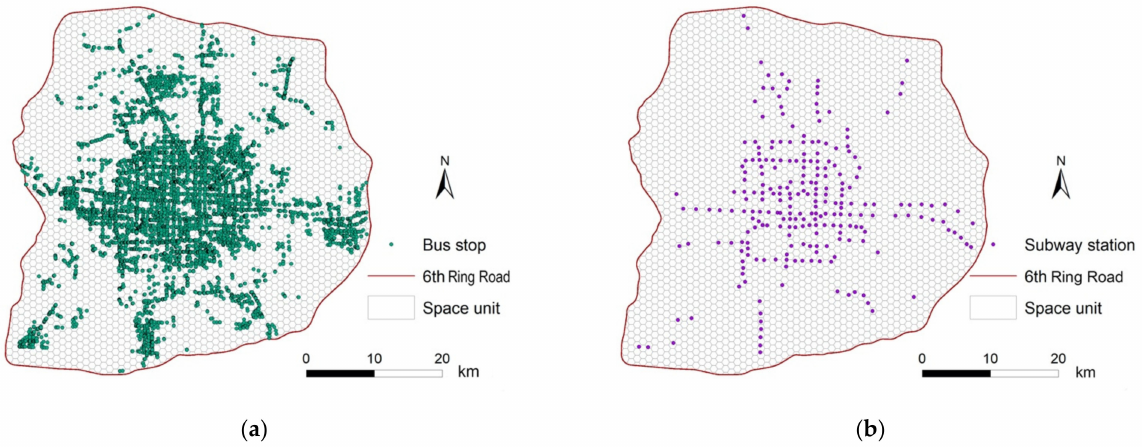
Figure 3. The distribution of public transport stations in Beijing: ( a ) bus stops; ( b ) subway